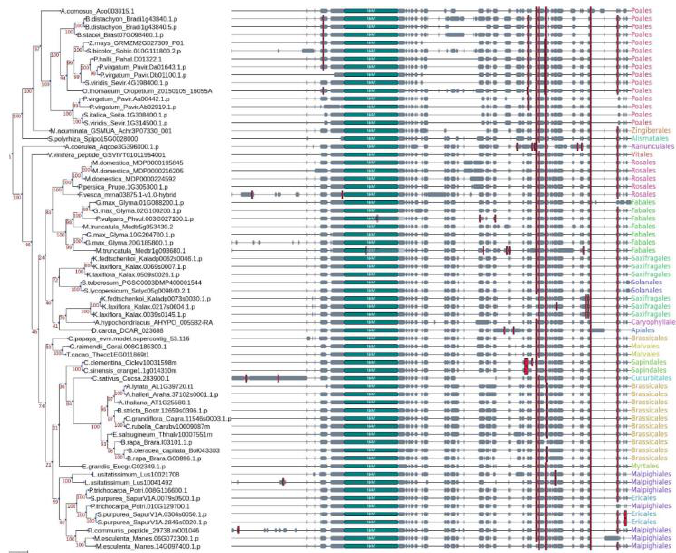
Figure 1. Phylogenetic Maximum Likelihood tree of the SOG1 gene family with the corresponding multiple sequence alignment. Bootstrap values are shown in red. The NAM domain is annotated in light blue and the SQ motifs are highlighted in red. The Order of each species is written in color- coded text on the right.